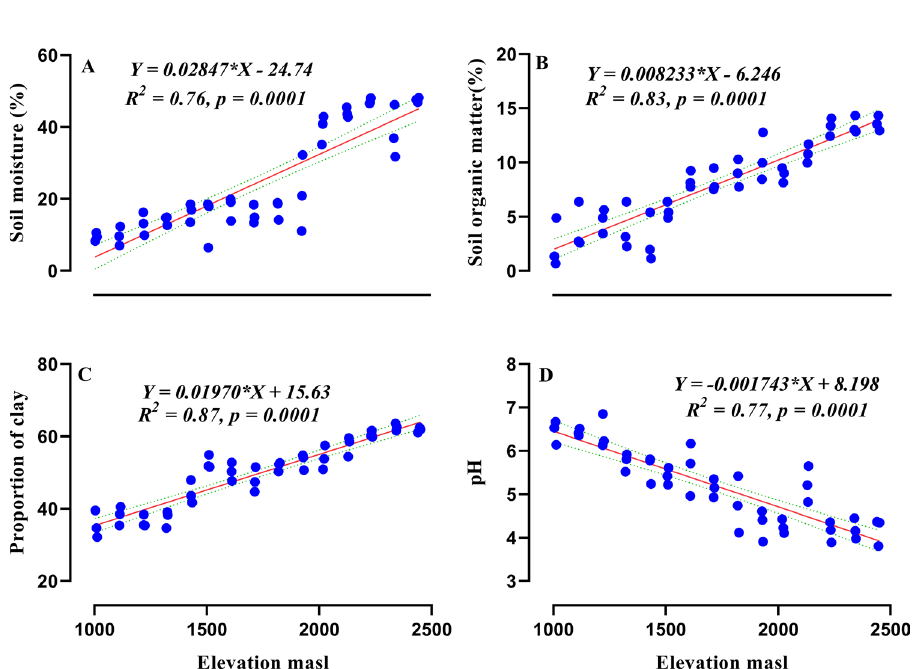
Figure 1. Effect of elevation on soil moisture ( A ), soil organic matter ( B ), proportion of clay ( C ) and pH ( D ). Equation for Y , R 2 (coefficient of determination), p value of linear regression line and dotted lines of 95% of confidence interval are